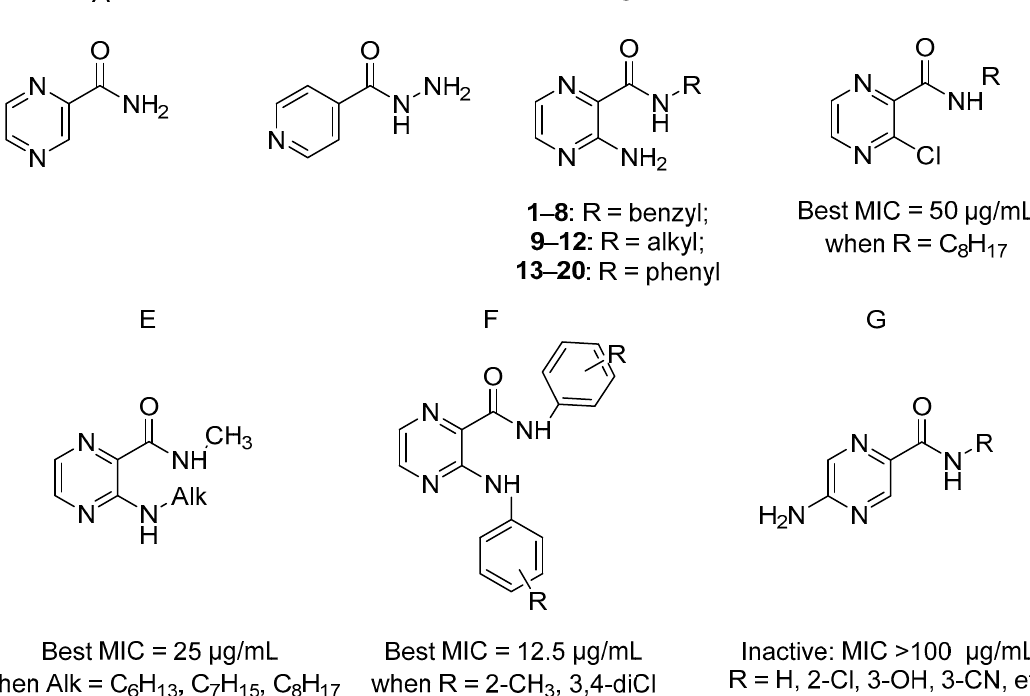
Figure 1. General structures of the discussed compounds (A: pyrazinamide; B: isoniazid (INH); C: current series; D: [14]; E: [14]; F: [15]; G: [16]) and best MICs against Mtb H37Rv.